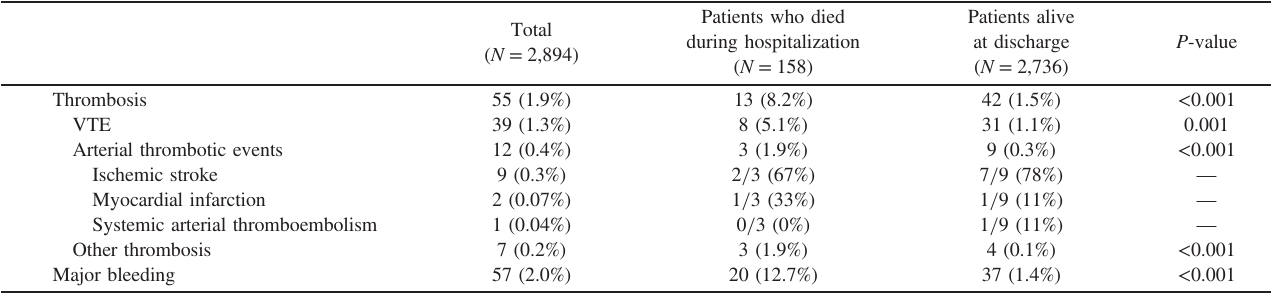
Table 2. Clinical outcomes during